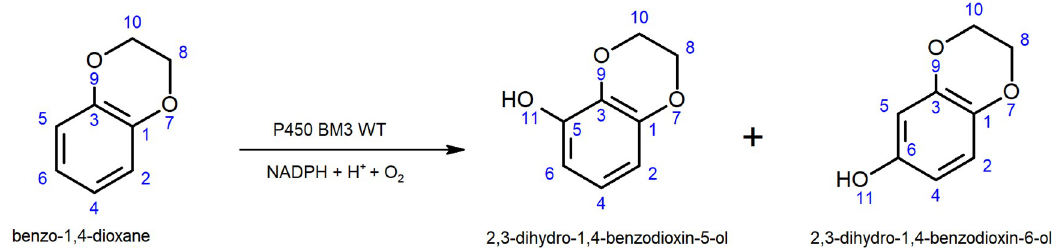
Figure 2. The hydroxylation of benzo-1,4-dioxane by cytochrome P450 monooxygenase (P450) Bacillus megaterium 3 (BM3) wild type (WT) leads to the formation of 2,3-dihydrobenzo-1,4-dioxin-5-ol and 2,3-dihydrobenzo-1,4-dioxin-6-ol at a 70/30 ratio.